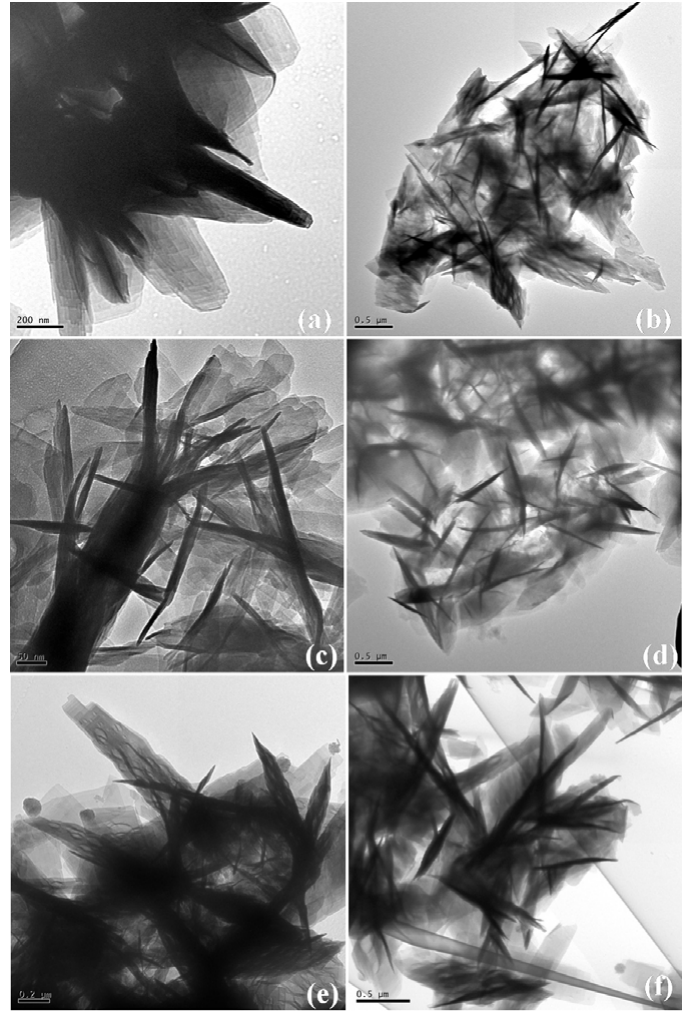
Fig. 3 TEM images for (a) undoped and 20%Yb 3+ /2%Er 3+ doped NaLuF 4 nanocrystals with different Gd 3+ contents: (b) 0% (c) 10% (d) 20% (e) 30% (f)